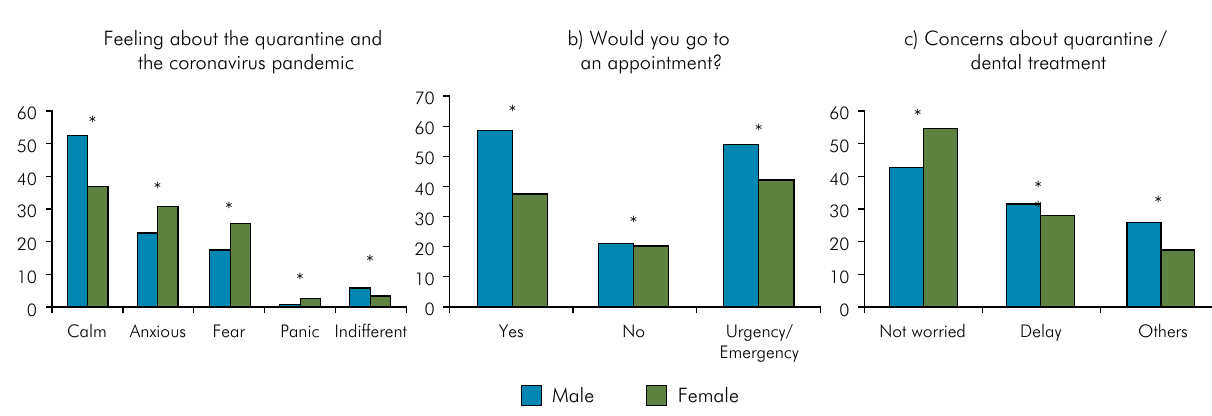
Figure 3. Comparison between the